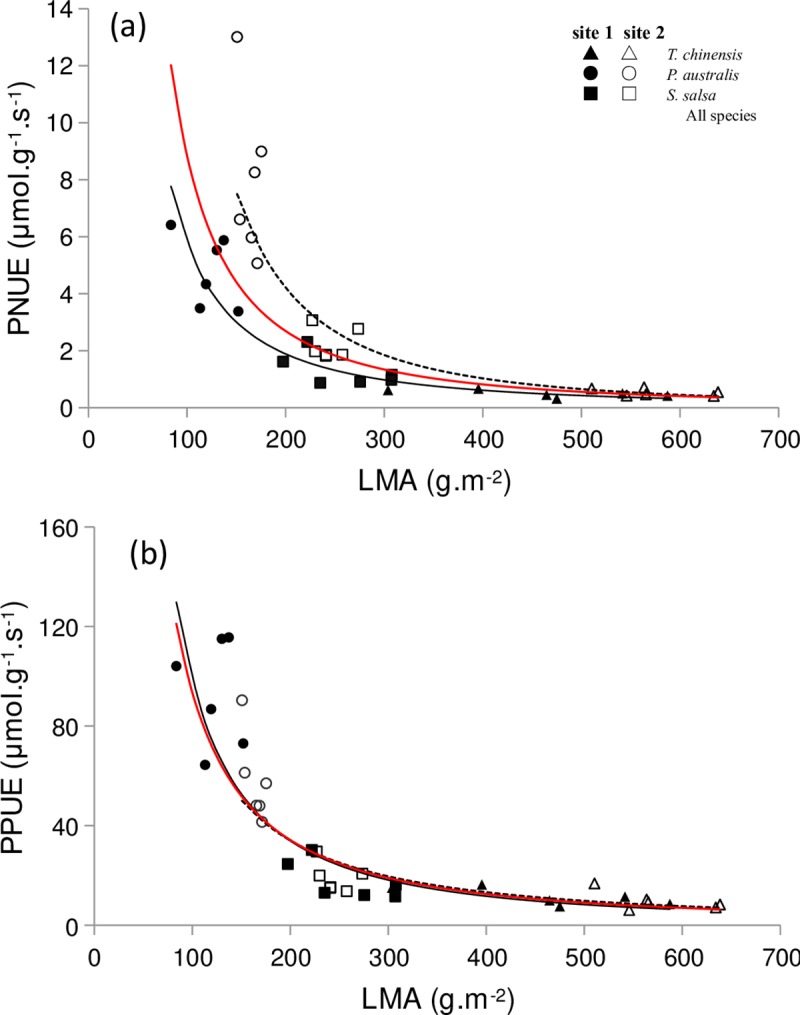
Relationships between LMA and photosynthetic nutrient use efficiency of halophytic plant communities.(a) LMA and PNUE (equation for site 1: y = 10339x−1.625, R2 = 0.909, P < 0.001; equation for site 2: y = 204171x−2.036, R2 = 0.923, P < 0.001; equation for all species: y = 24214x−1.719, R2 = 0.805, P < 0.001); (b) LMA and PPUE (equation for site 1: y = 118828x−1.54, R2 = 0.849, P < 0.001; equation for site 2: y = 45843x−1.36, R2 = 0.812, P < 0.001; equation for all species: y = 74475x−1.451, R2 = 0.832, P < 0.001).